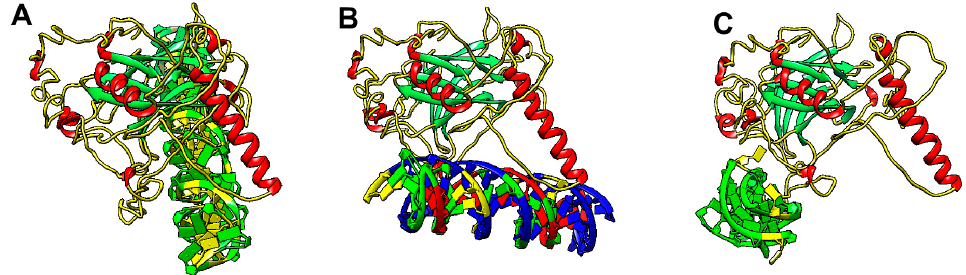
Figure 2. In silico model of human p53 interactions with Z-DNA ( A ), Triplex DNA ( B ) and G-quadruplex DNA ( C ). Visualized using Chimera software, Protein: helices-red, beta-sheets-green, DNA: A–blue, C–yellow, G–green, T–red.